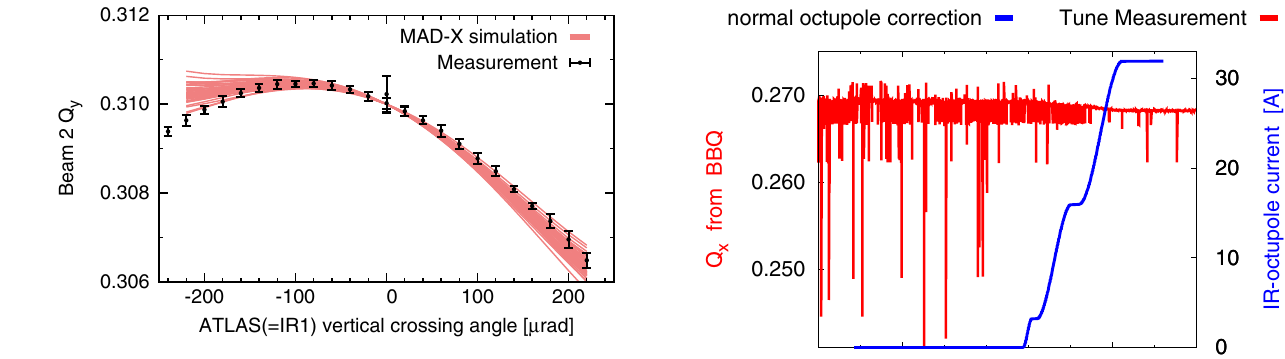
FIG. 6. Measured tune (black) as a function of the vertical crossing angle in the ATLAS (IR1) insertion, compared to predictions based upon magnetic measurements (red).